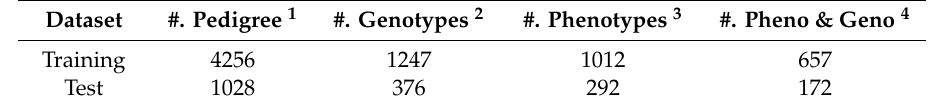
Table 2. Data structure of the training and test population in the forward prediction scenario. Boars from the 1st to 9th and the 10th to 11th generations were treated as training and test groups, respectively.